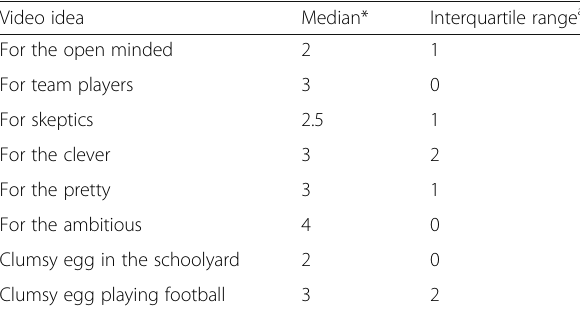
Table 3 Acceptance of different ideas for videos